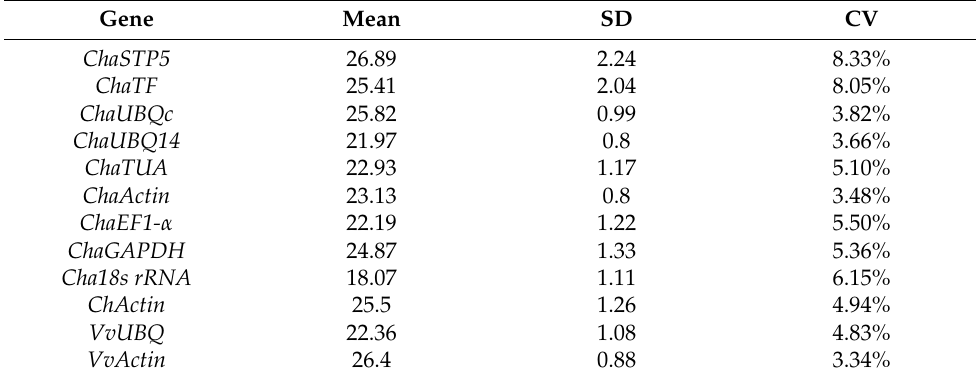
Table 3. Statistical analysis of candidate reference gene Cq